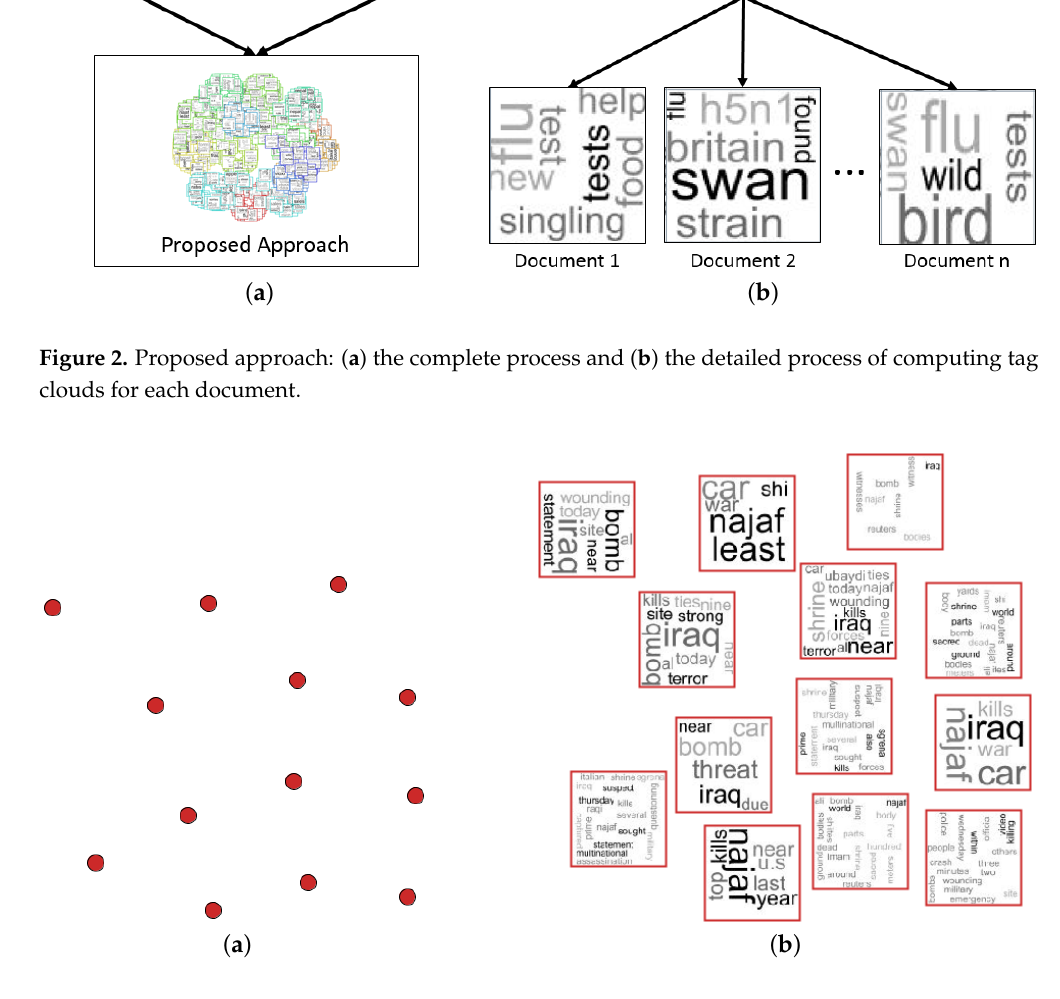
Figure 3. Example of application: ( a ) a 2D projection of a document collection and ( b ) the tag cloud images mapped as visual